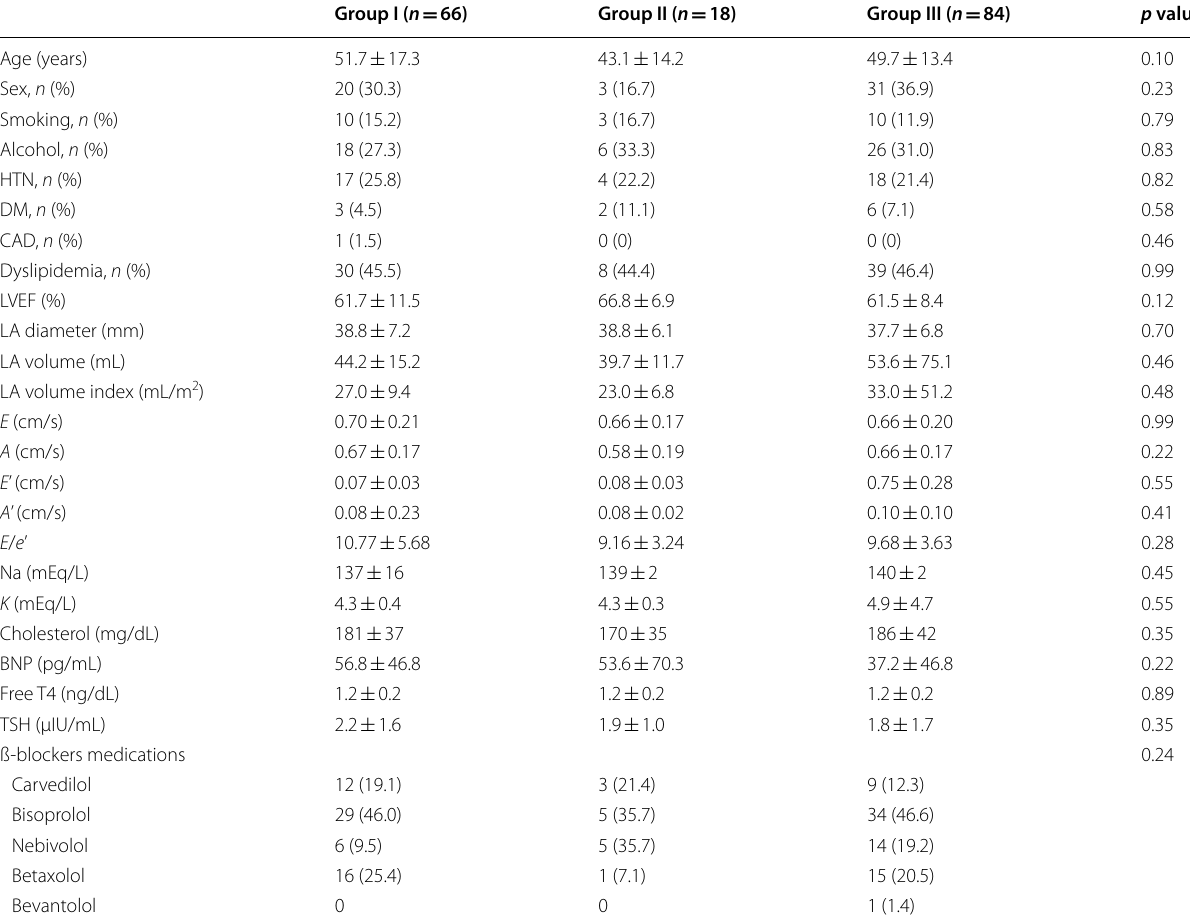
Table 1 Baseline characteristics according to groups